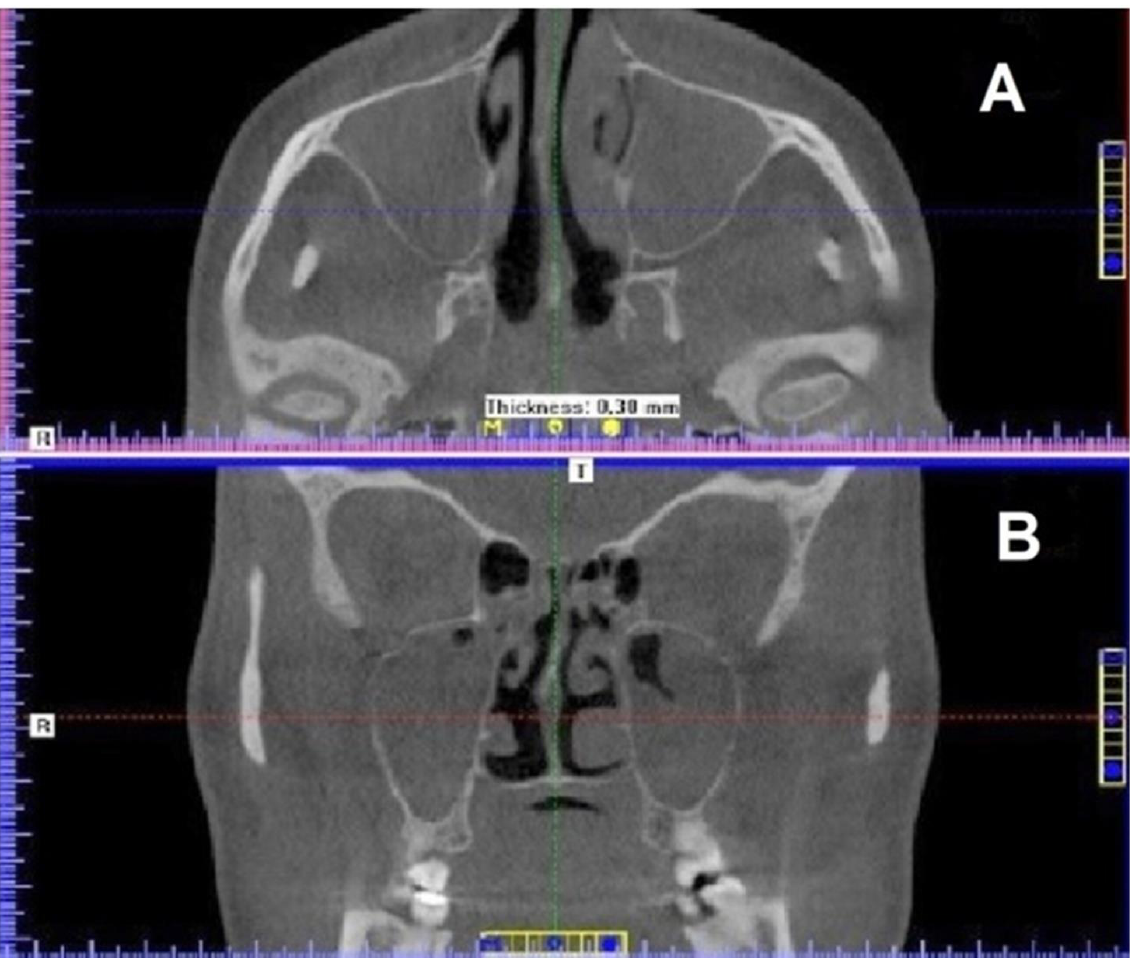
Figure 1. Maxillary sinuses visualized as dark (low-density) areas. ( A ) axial view; ( B ) coronal view (CBCT scans).